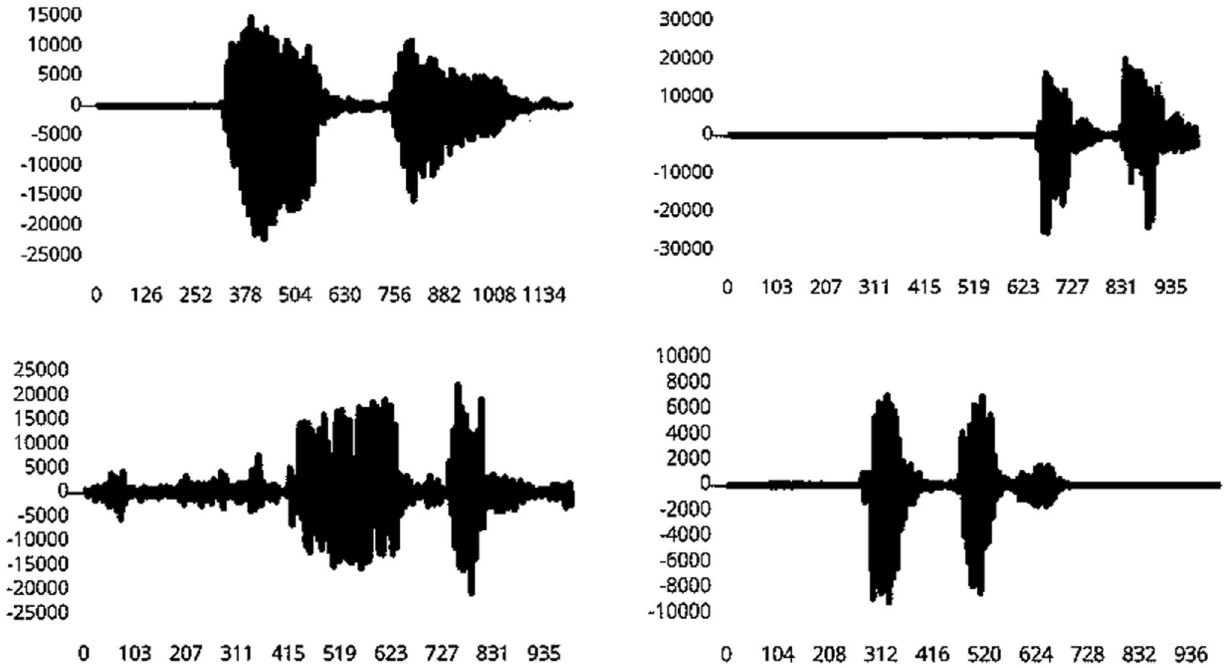
Fig. 3 Different samples of the word “Open” in time frequency domain from the dataset with the label “Adult”